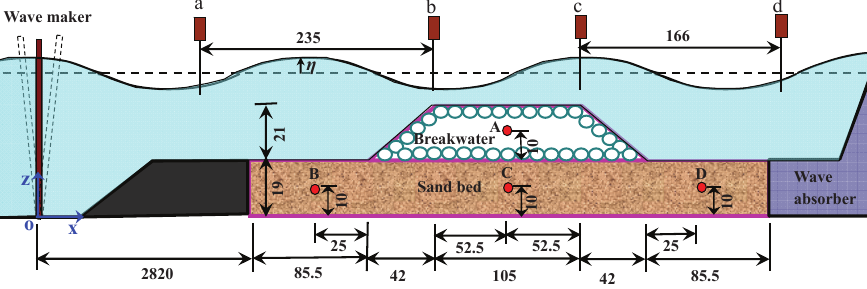
Figure 1. Experiment set-up of Mizutani and Mostafa [48]’s tests. The side slopes of the breakwater are 2:1 (horizontal:vertical). The length of the computational domain is determined as 10.8 m. According to Ye and Jeng [49], it is long enough to ensure that the effect of lateral boundary conditions on the soil area around the breakwater is vanished. As shown in Figure 1, four wave gauages are installed at points a, b, c and d to monitor the wave profile, while four pore pressure transducers are installed at point A, B, C, and D to record the wave-induced pore pressure. The wave gauage at Point a is to measure the incident wave height, at point b and c are to determine the wave profile at edge of top of the submerged breakwater, and Point d is to check the wave reflection form the end of the wave flume. Point A is located inside the breakwater on the line of 9.9 cm above the seabed surface, which is used to record the pore water pressure in the middle of the submerged breakwater. Transducers B, C, and D are embedded in the soil on the section of 9 cm below the seabed surface. C is utilized to record the pore water pressure inside the soil foundation under the middle of the breakwater. Moreover, B and D are